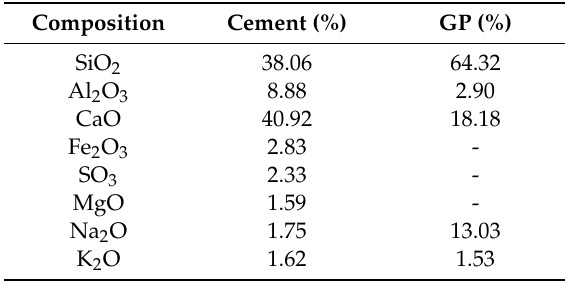
Table 1. Chemical properties of cement and Glass powder